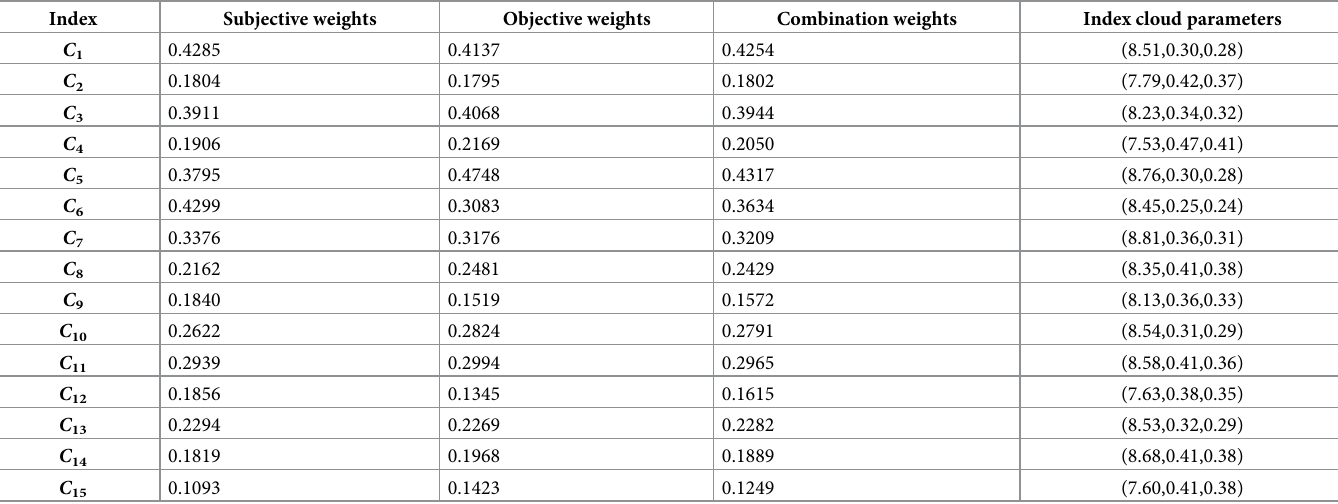
Table 3. Index weights and index cloud parameters.